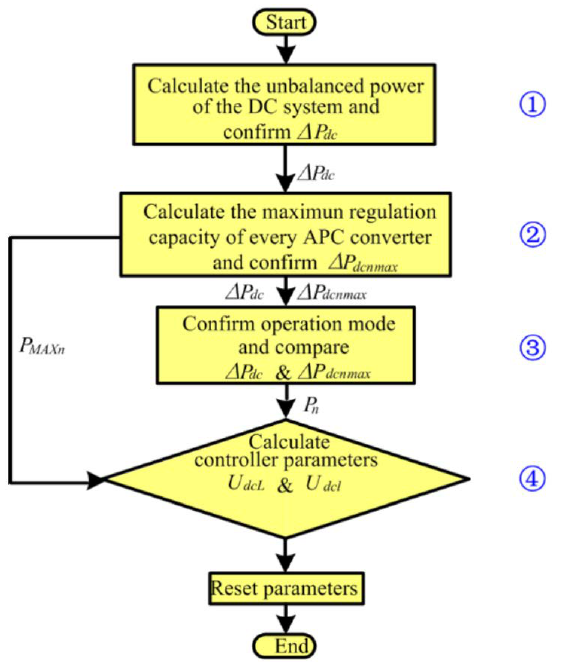
Figure 6. Flowchart of the complete calculation procedure of the proposed